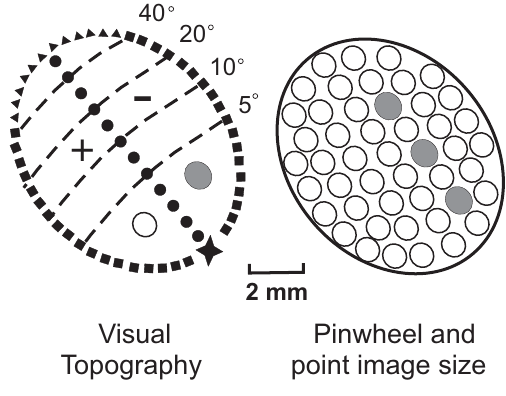
Fig. 6 – Visual map of MT and dimensions of point image size (gray circle) and radial arrangements (open circle) of direction selectivity. Star, foveal representation; black squares, vertical meridian; filled circles, horizontal meridian; dashed lines, iso- eccentricity lines; triangles,